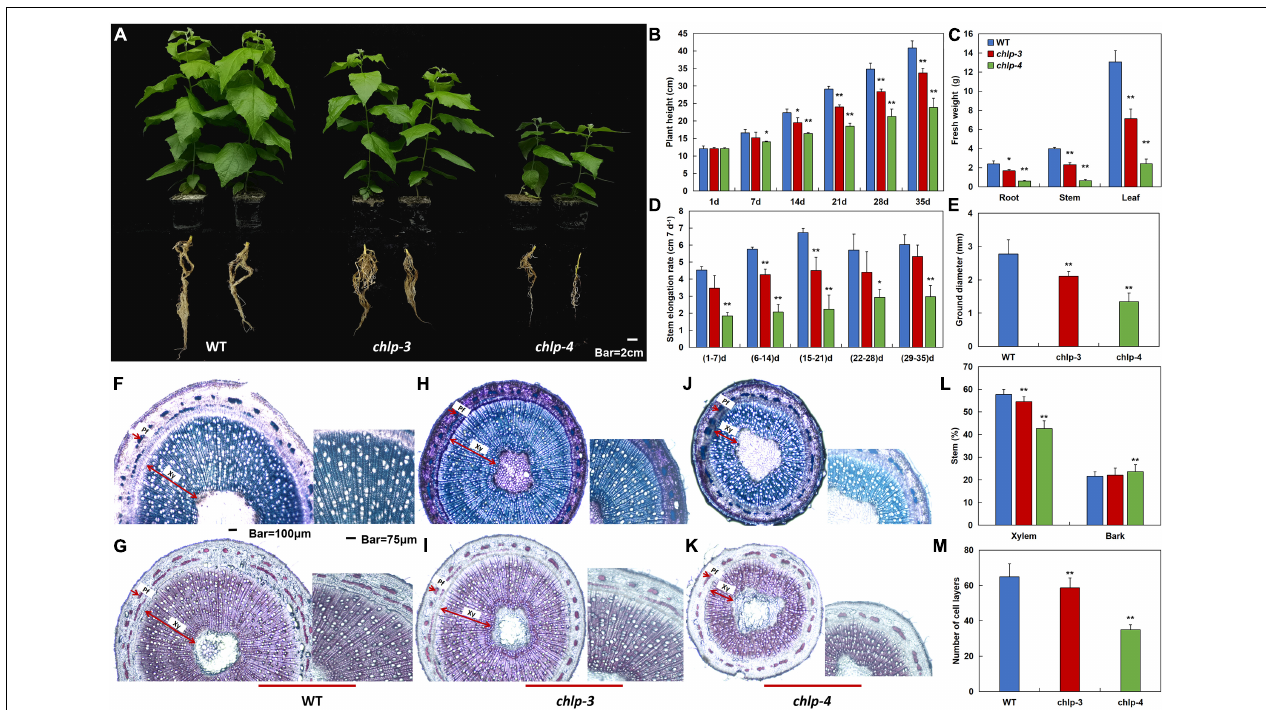
FIGURE 5 | PtrCHLP3 positively regulates poplar growth. (A) Scrubby appearance of 35-day-old plants of independent PtrCHLP3-RNAi transgenic lines ( chlp3 and 4 ). (B–E) The values of plant height (B) , fresh weight (C) , stem elongation rate (D) , and stem diameter (E) of WT and chlp plants. (F–K) Transection and staining via toluidine blue (F,H,J) and phloroglucinol-HCl (G,I,K) of the 8th internode of WT and chlp plants. Pf, phloem fibers; Xy, xylem. (L) Secondary xylem (%) and bark (%) in stem between WT and chlp poplars. The scope of secondary xylem, bark, and total stem was counted using ImageJ in toluidine blue- and phloroglucinol-stained anatomical segments of the 8th internode of WT and chlp poplars. (M) Quantification of secondary xylem cell layers in WT and chlp poplars. The amount of secondary xylem cell layers was calculated in toluidine blue- and phloroglucinol-stained anatomical segments of the 8th internode of WT and chlp plants. The value represents the mean ± standard deviation ( n = 120). Asterisks indicate a significant difference at the same level: ** indicates P <